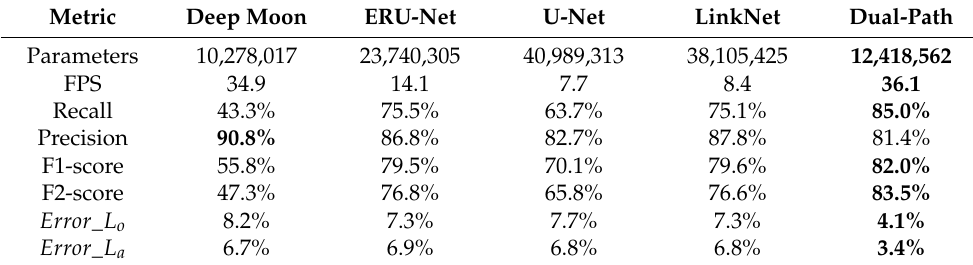
Table 5. Model performance on the testing set for our Dual-Path model and four competitive models.